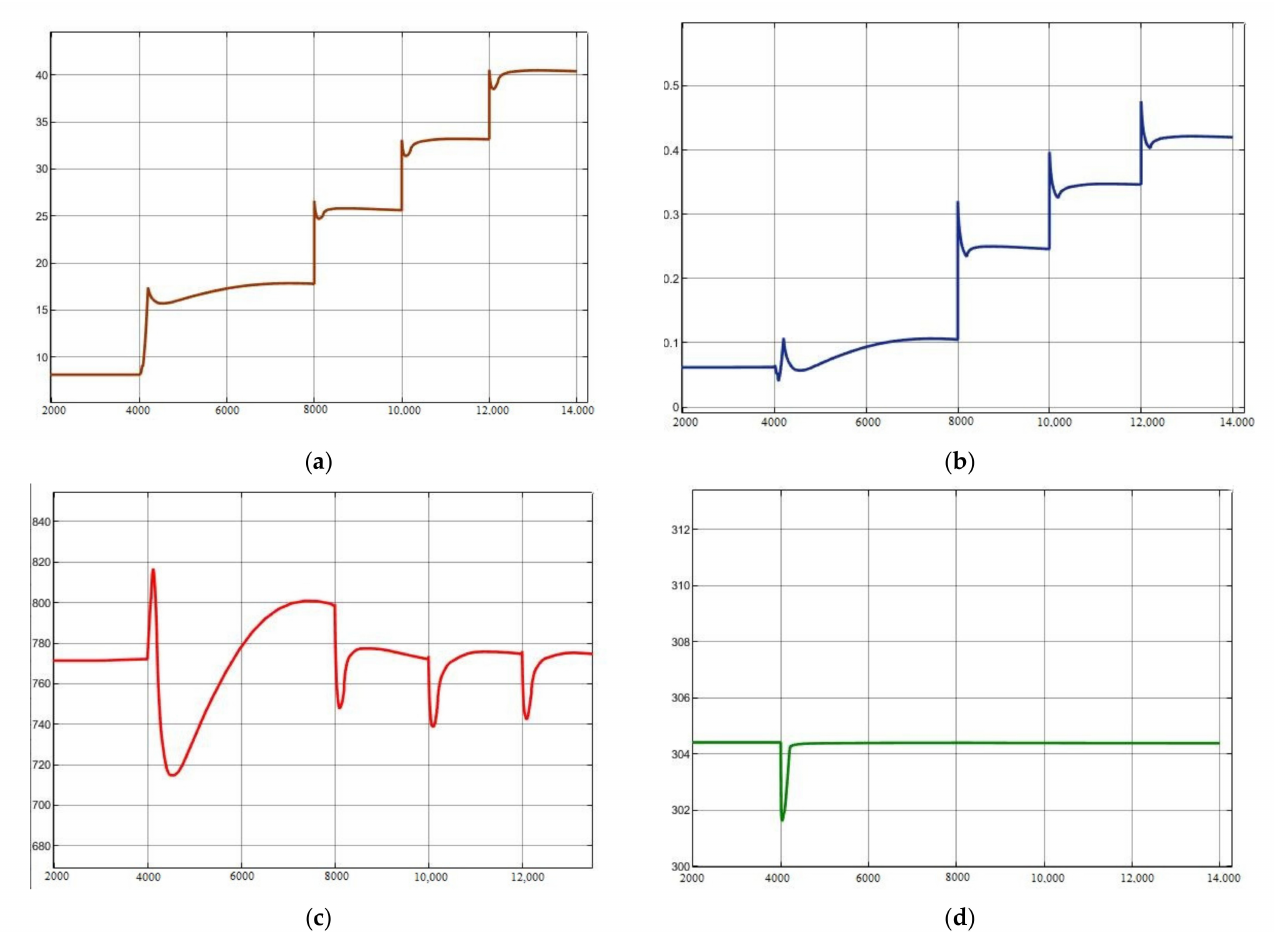
Figure 10. The system dynamic characteristics of the load-increasing process. ( a ) Turbine output power. ( b ) circle efficiency. ( c ) Turbine inlet temperature. ( d ) Compressor inlet temperature.